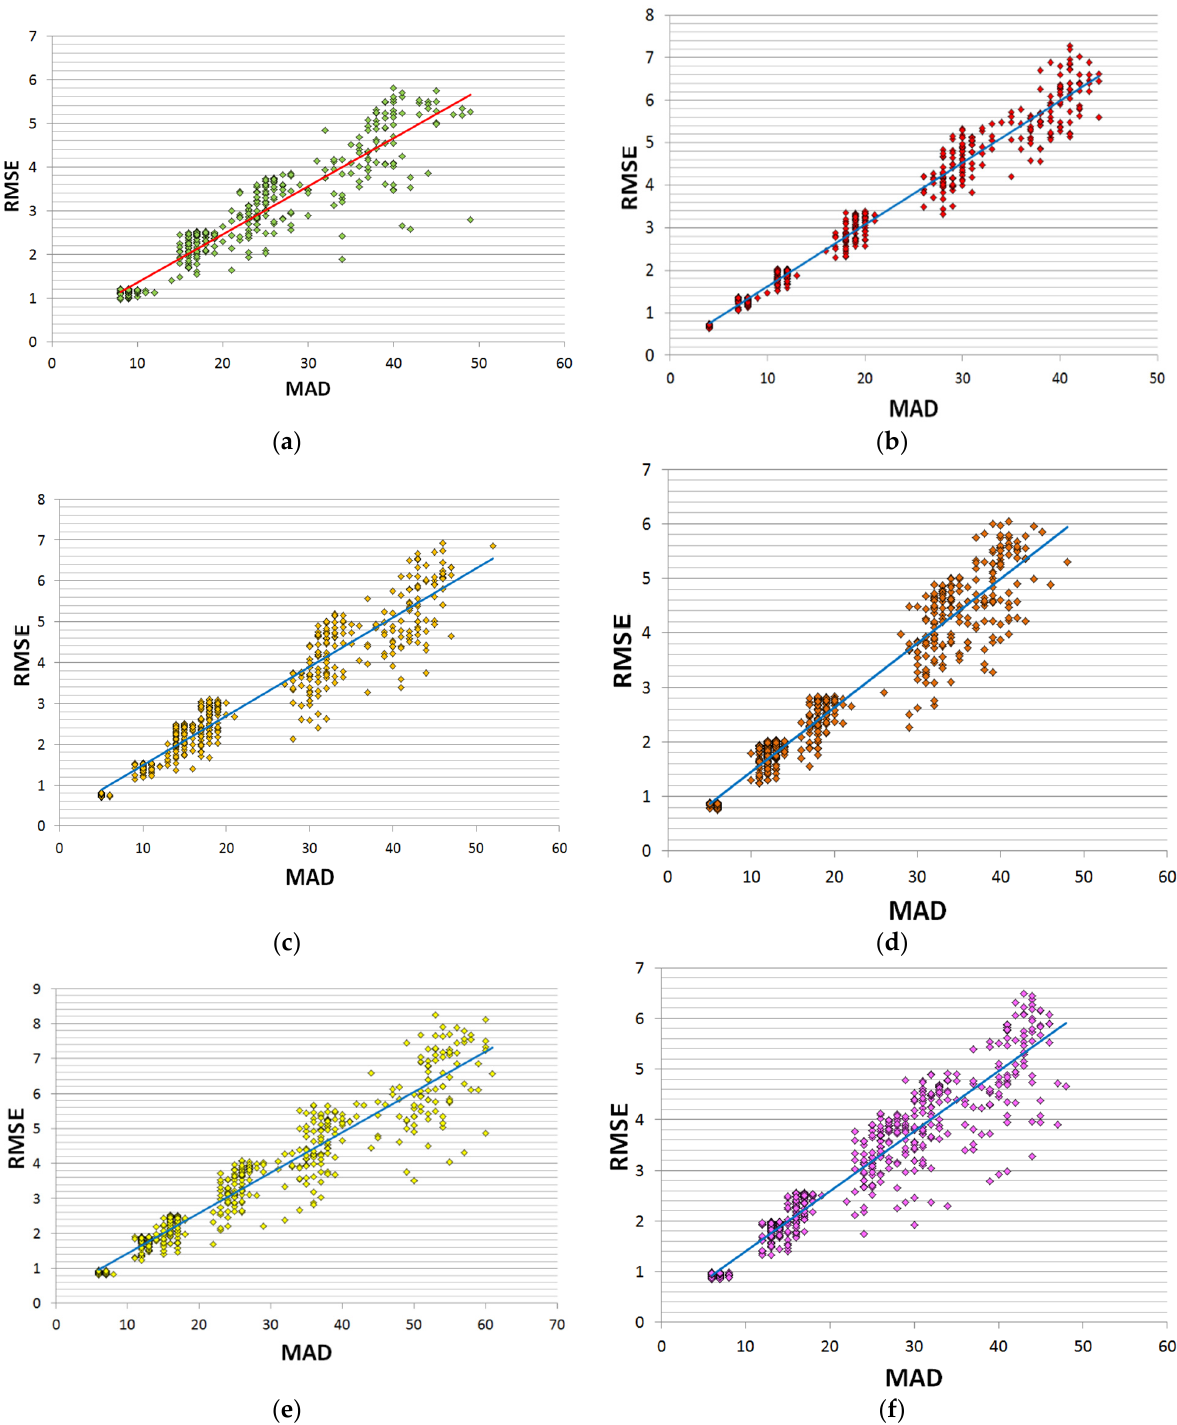
Figure 10. Scatter plots of RMSE vs. MAD for the test images processed by DAC with different structures of DAT: DAT1 of the depth 5 ( a ), DAT2 of the depth 1 ( b ), DAT2 of the depth 2 ( c ), DAT2 of the depth 3 ( d ), DAT2 of the depth 4 ( e ), DAT2 of the depth 5 ( f ). Table 1. Indicators of correlation of MAD and RMSE for different structures of DAT.